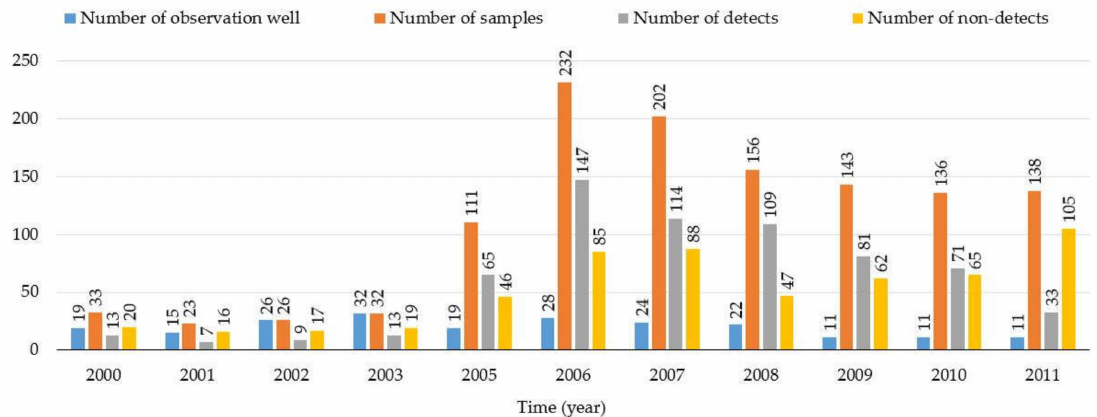
Figure 15. The number of observation wells, samples collected, samples with detects and non-detects from the monitoring program in the Zwischenscholle aquifer [20,21].